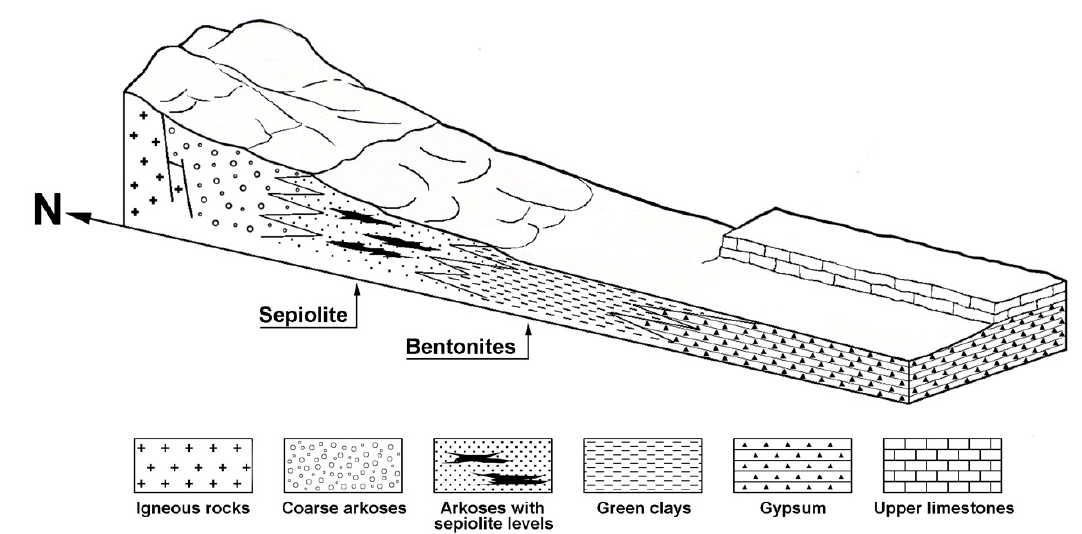
Figure 2. Facies distribution in the Madrid Basin from the Central System to the evaporitic deposits. Modified from Reference [74].